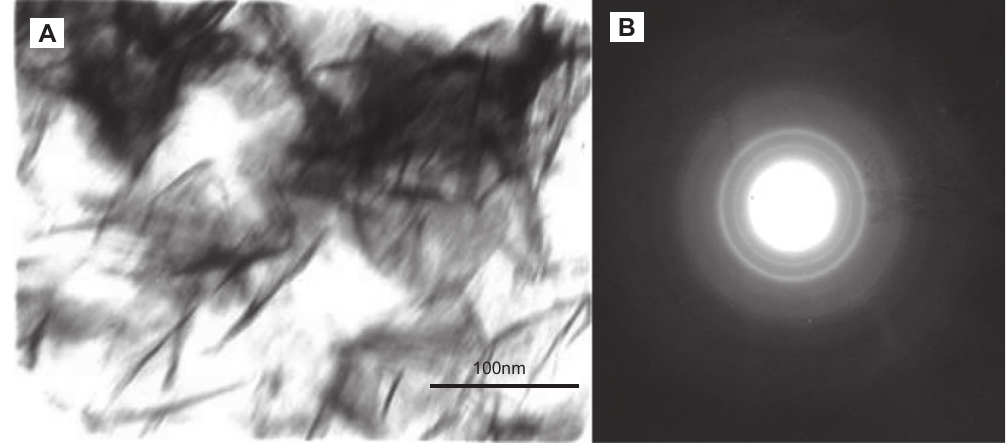
Figure 3 (A) TEM photo of HAp/Col-48 composite; (B) electron diffraction graphic of HAp/Col-48